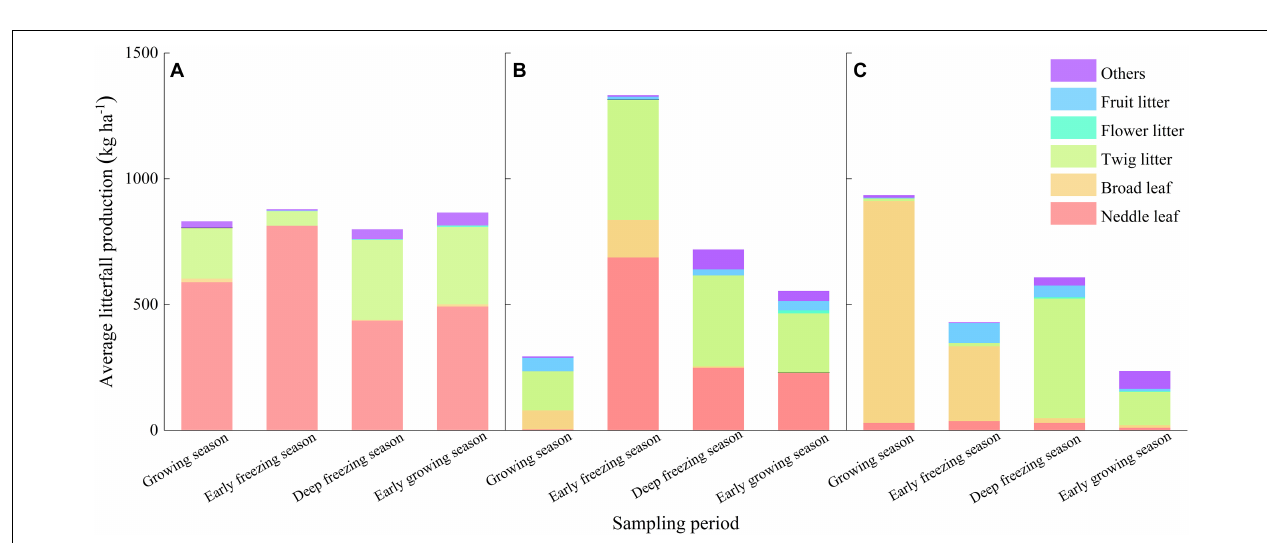
FIGURE 1 | Daily mean temperature of the soil and air and the monthly mean relative humidity of the air in a subalpine forest on the eastern Tibetan Plateau from May 11, 2017 to May 30, 2018.